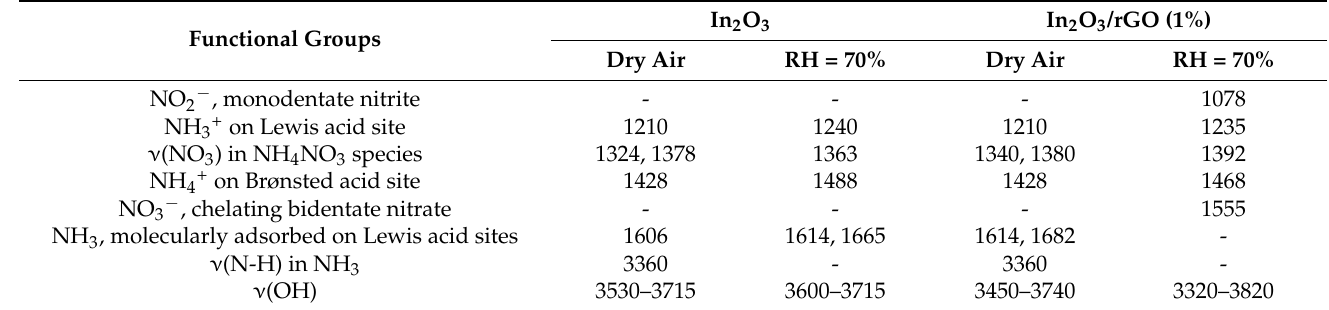
Table 2. Assignments of IR absorption bands (cm − 1 ) that appeared in the DRIFT spectra on the surface of In 2 O 3 and In 2 O 3 /rGO (1%) samples under different